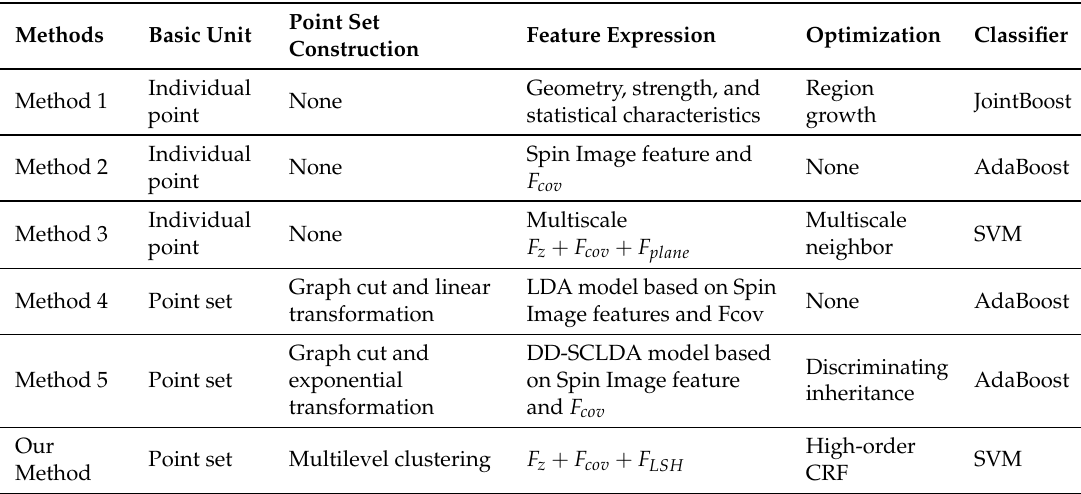
Table 3. Comparison with five methods in terms of “Basic Unit”, “Point Set Construction”, “Feature Expression”, “Optimization”, and